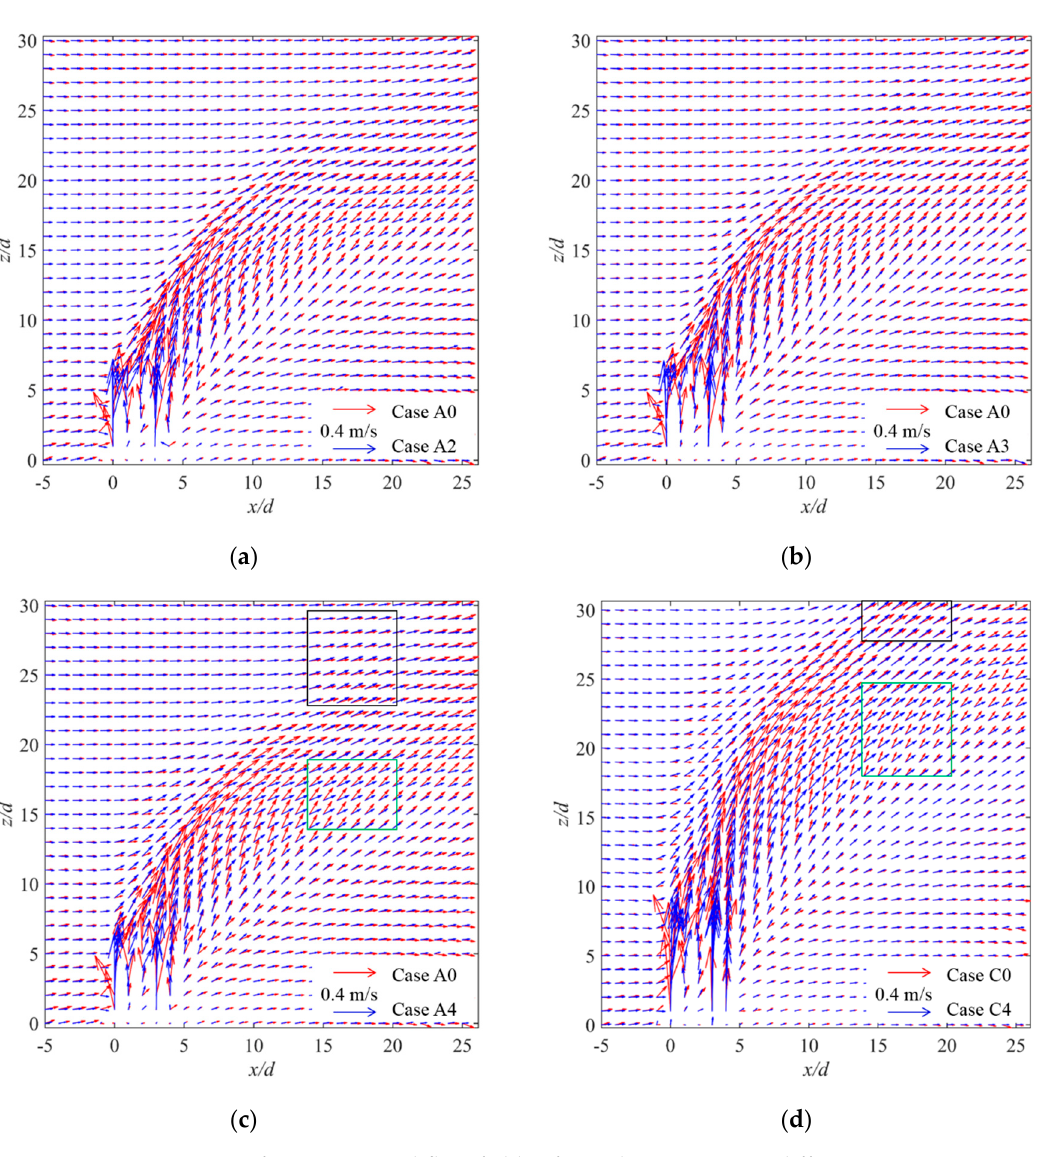
Figure 7. Comparison of time-averaged flow fields of twin buoyant jets in different environments: ( a ) Case A0 vs. Case A2; ( b ) Case A0 vs. Case A3; ( c ) Case A0 vs. Case A4; ( d ) Case C0 vs. Case